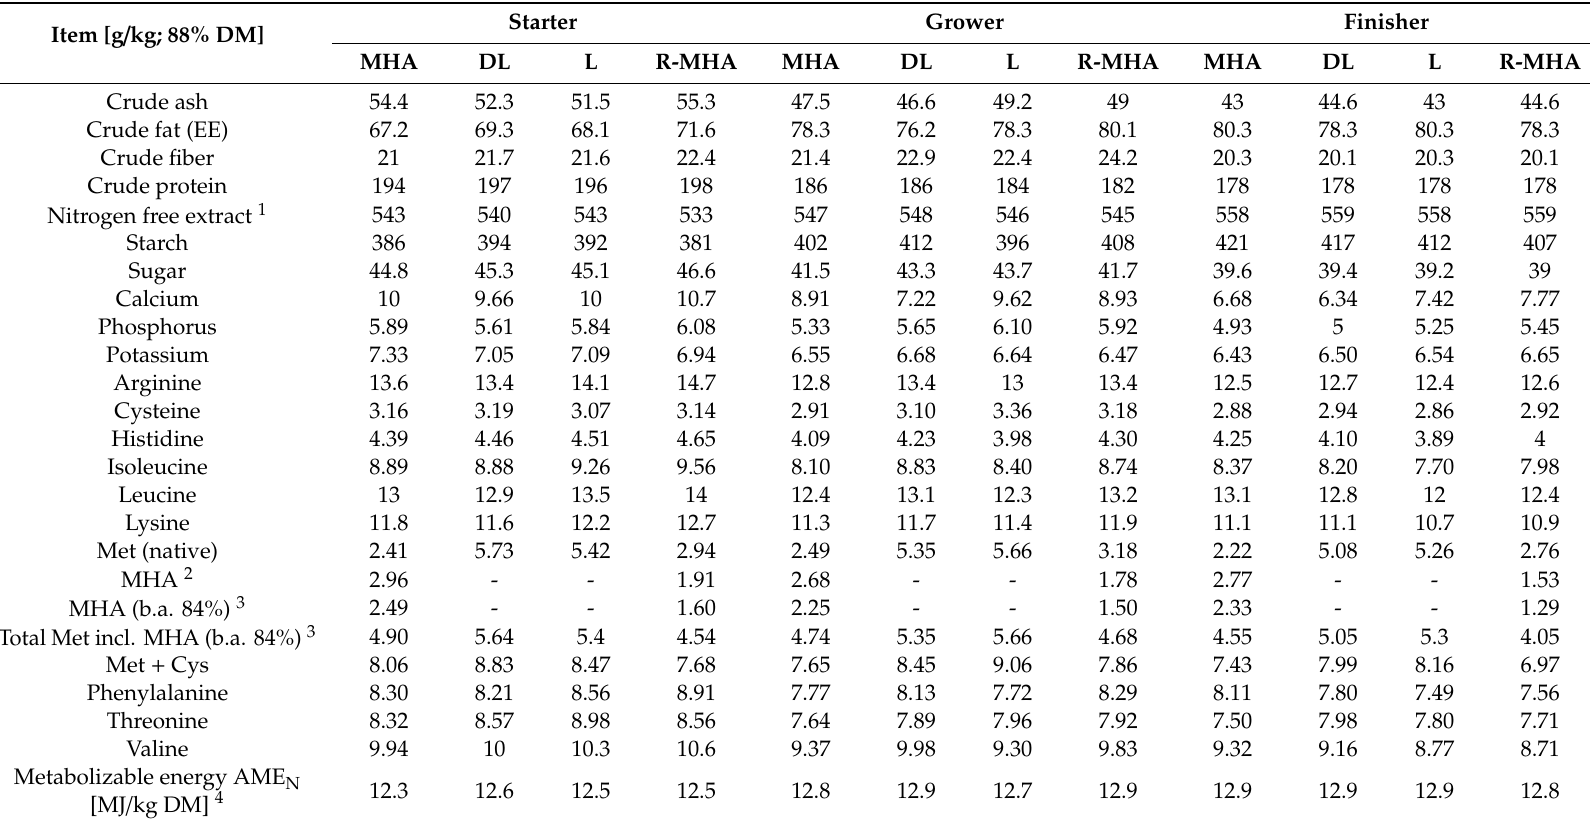
Table 3. Concentrations of ingredients after chemical analysis in the starter, grower, and finisher